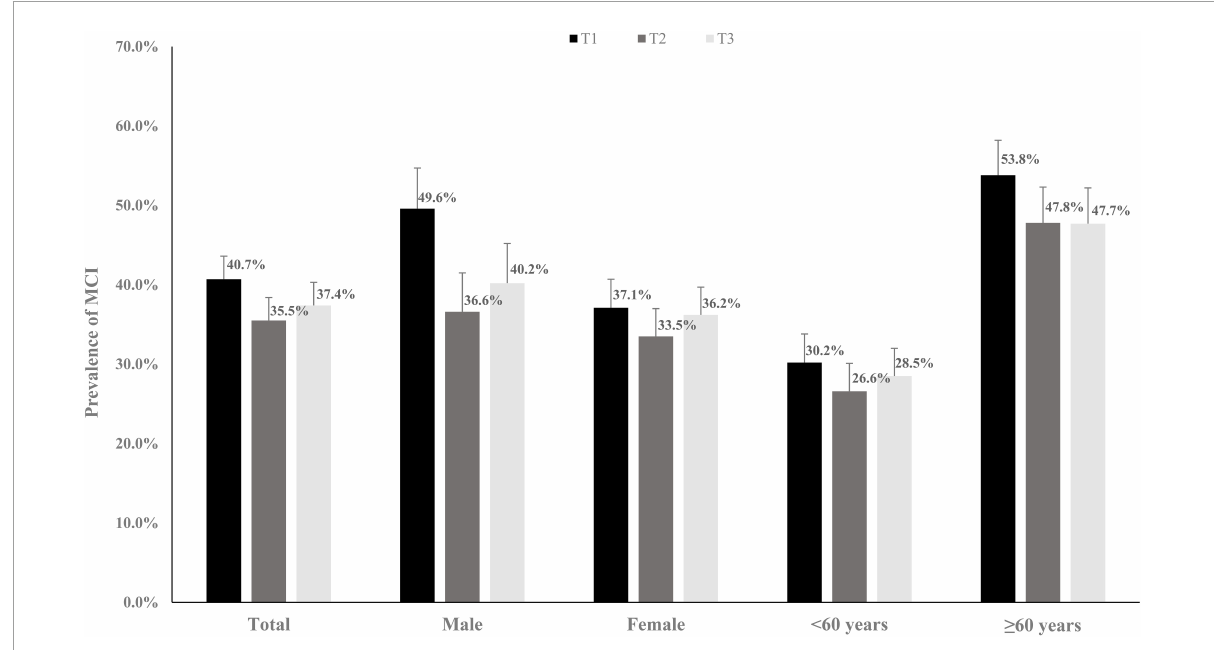
FIGURE2 The prevalence rates (95% CI) of mild cognitive impairment (MCI) grouping by different spermidine (SPD)